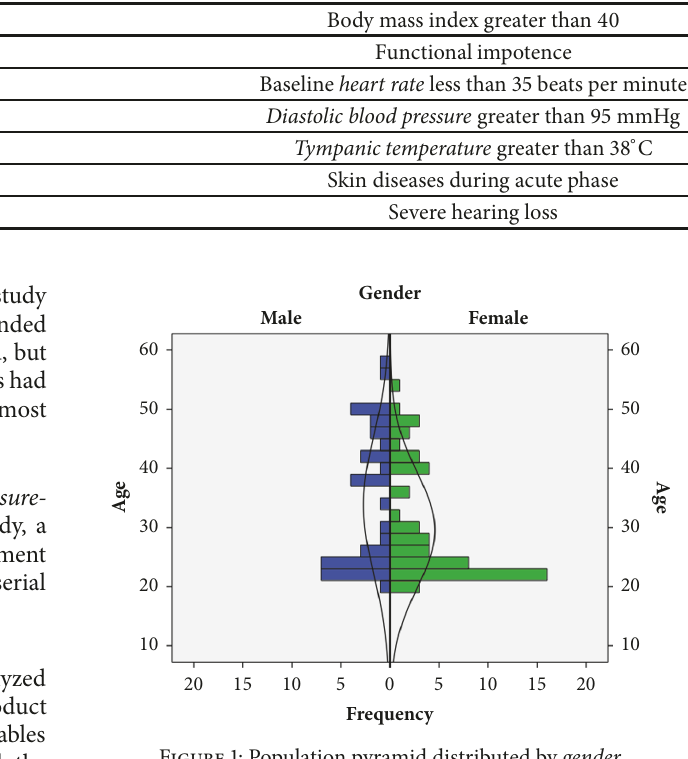
Figure 1: Population pyramid distributed by